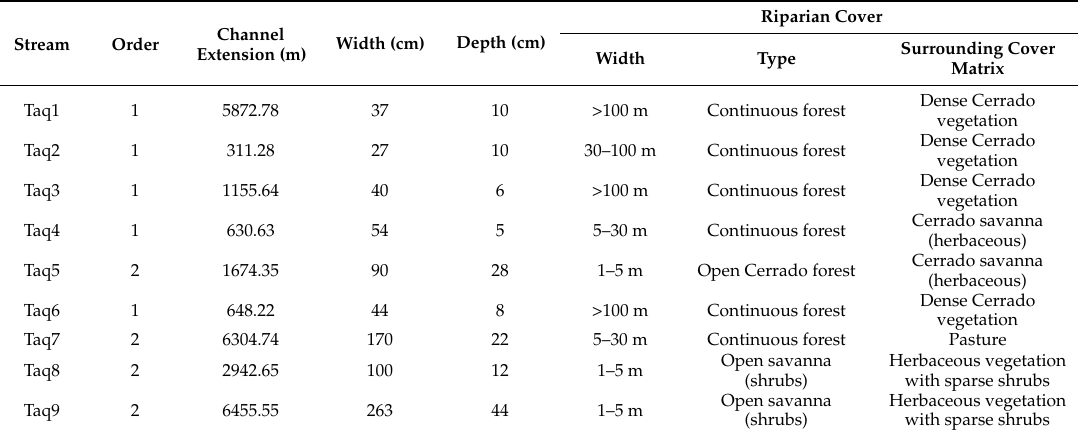
Table 1. Physical and chemical characterization of nine streams in the Taquaruçu Grande river basin, State of Tocantins,